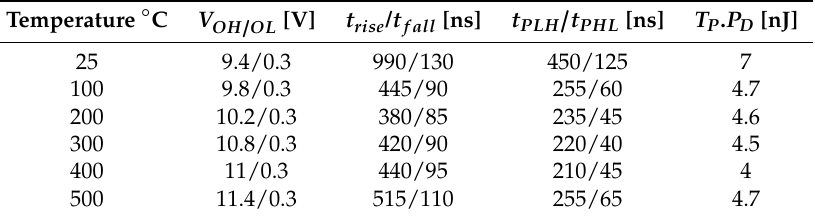
Table 2. Measured performance of TTL INVERTER over temperature range of 25 to 500 ○ C. Temperature ○ C V OH / OL [V] t rise / t fall [ns] t PLH / t PHL [ns] T P . P D